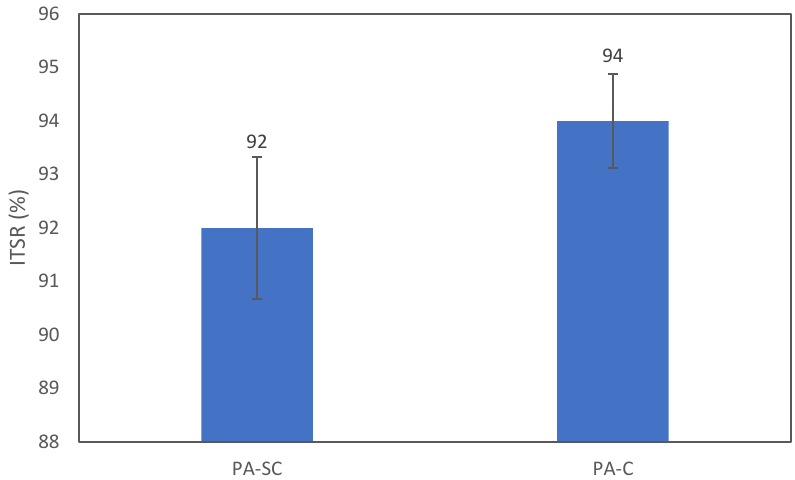
Figure 4. Average ITSR results for porous samples.